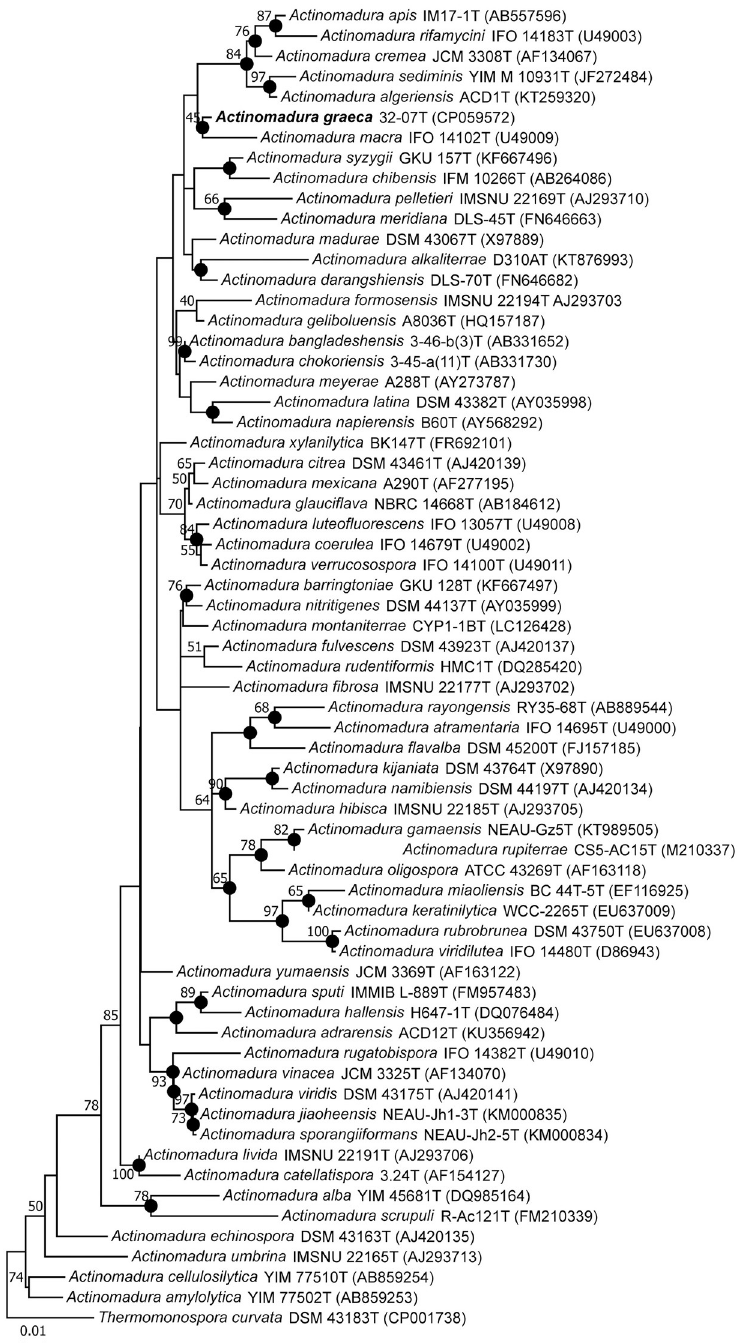
Fig 1. Maximum likelihood tree generated from nearly complete 16S rRNA gene sequences showing the relationship between Actinomadura sp. 32–07 and the type strains of species with validly published names in the genus Actinomadura . Thermomonospora curvata DSM 43183 T was used as an outgroup. The tree with the highest log likelihood is shown. The percentage of replicate trees in which the associated taxa clustered together in the bootstrap test (1000 replicates) is shown next to the branches (only values above 40% are shown). The tree is drawn to scale, with branch lengths measured in number of substitutions per site (bar = 0.01 substitutions per site). Nodes marked with a full circle were also recovered in the neighbour-joining and maximum parsimony trees. T’s at the end of strain names indicate type strains.